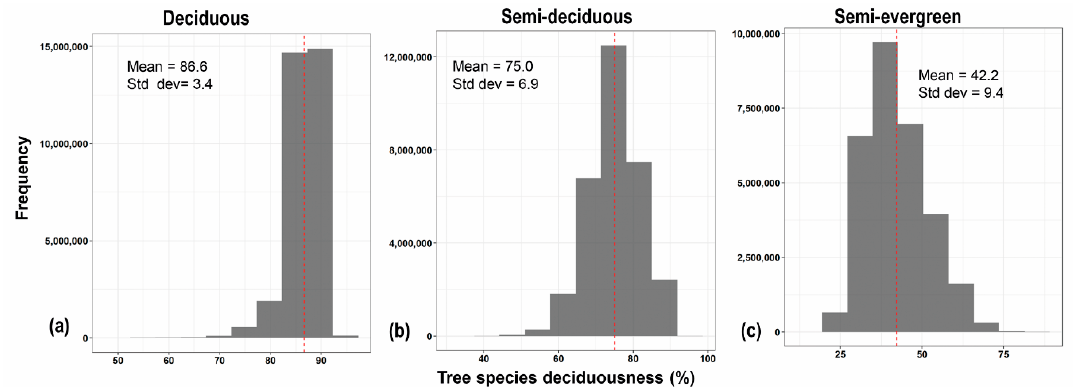
Figure 6. Frequency distribution of estimated tree species deciduousness in a 3600 km 2 window of three types of tropical dry forest: deciduous ( a ), semi-deciduous ( b ), and semi-evergreen ( c ).